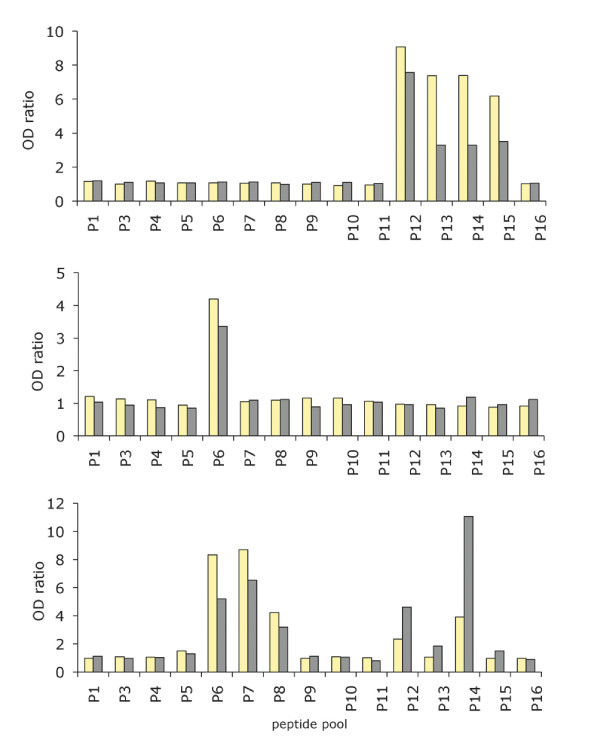
Typical profiles of the temporal evolution of MSP1 block2- specific IgG before and after the 1998 rainy season. Antibodies were assayed from 25 individuals in August 1998 (yellow) and December 1998, i.e. after a rainy season when each inhabitant was exposed to a mean of 170 infected bites. Anti-MSP1 block2 specific IgG was assessed by ELISA on 16 pools of biotinylated peptides. The upper, central and lower panels show a representative example of a reduction of specific antibodies, an essentially unchanged profile, and a boosting of pre-existing responses, respectively.